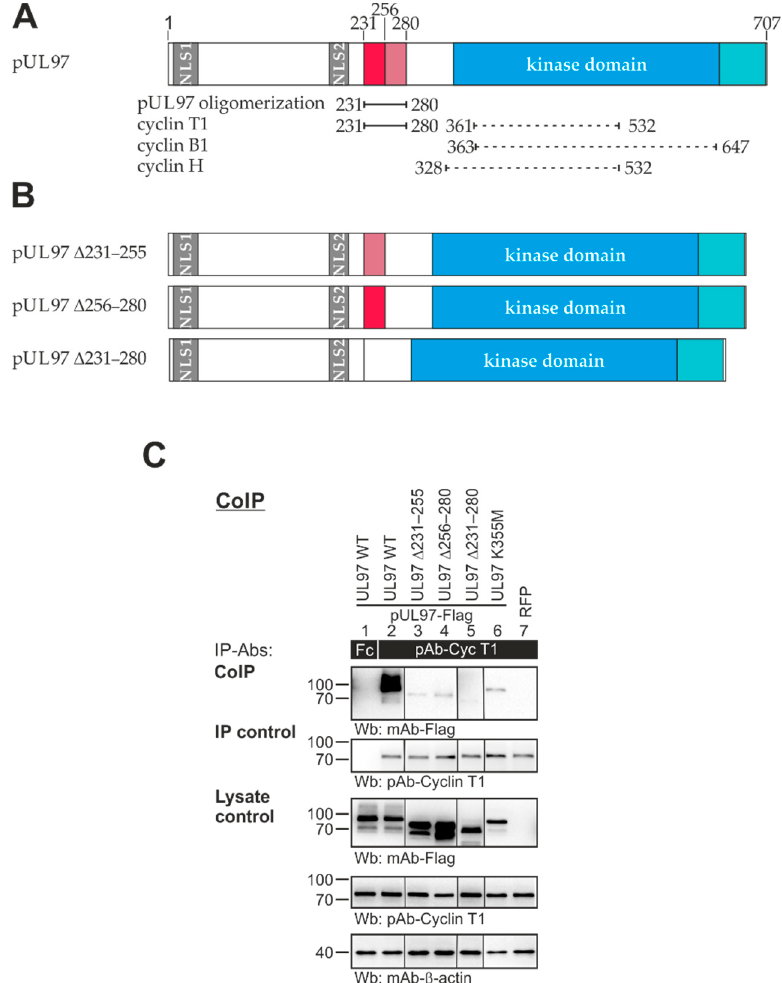
Figure 1. Schematic view of ORF-UL97 constructs used in this study. ( A ) Wild-type pUL97 and currently identified binding regions for pUL97 oligomerization as well as binding to human cy- clin T1, B1 and H are depicted. The N-terminus contains two nuclear localization signals (NLS). Oligomerization of pUL97 and binding to cyclin T1 is determined by amino acid region 231–280. Recombinant viruses were generated harboring deletions within this region (red shading). Modeling of in silico binding interfaces predicted extended interfaces for cyclin T1, B1 and H (dashed lines). The catalytically active kinase domain is, based on sequence homologies, located between amino acids 337 and 651 (blue). This domain can be extended to 706 based on biochemical validation (turquoise). ( B ) Recombinant viruses generated for this study. A Red recombination system was used to generate deletion mutants UL97 ∆ 231–255, ∆ 256–280 and ∆ 231–280 from the parental BACmid HB5/AD169-GFP. ( C ) 293T cells were transiently transfected with plasmids coding for pUL97-Flag WT or mutant versions (K355M is a catalytically inactive replacement mutant). Transfection with an RFP-coding plasmid was used as negative control. At 2 d post-transfection, cells were lysed and human cyclin T1 was immunoprecipitated using specific Abs; a rabbit Fc fragment served as specificity control. Subsequently, CoIP samples and lysate controls taken prior to the addition of IP-Abs were subjected to standard Wb analysis using specific Abs as